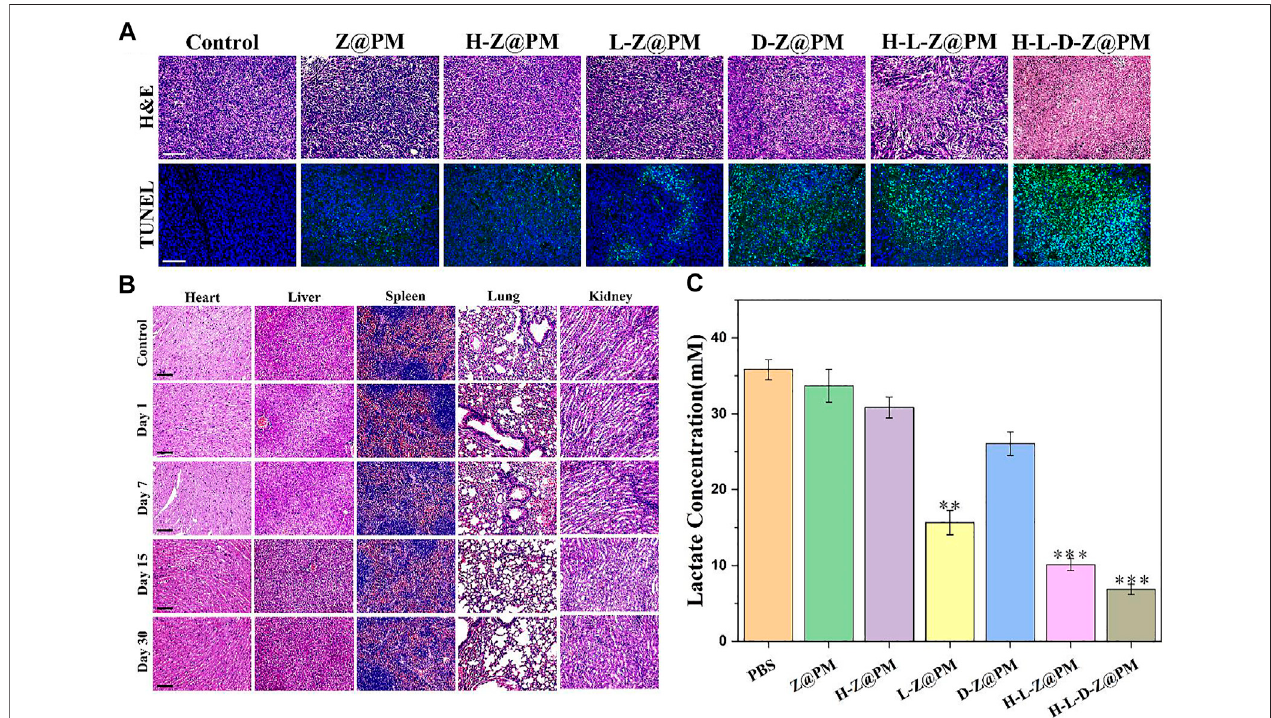
FIGURE 7 | (A) Fluorescence microscopy images of H and E- and TUNEL-stained tumor sections after different treatments. Scale bar: 100 µm. (B) Long-term toxicity of H-L-D-Z@PM NPs in the heart, liver, spleen, lungs, and kidney at days 1, 7, 15, and 30 using H and E staining. Scale bar: 100 µm. (C) Tumor lactate concentration after different treatments. ** p < 0.01, *** p <